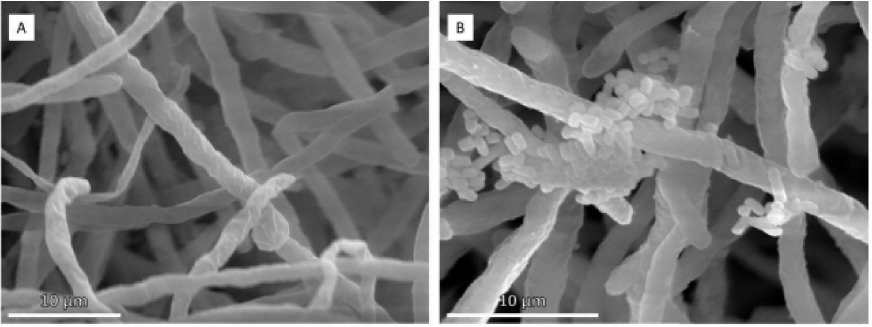
Figure 5. Scanning electron micrographs of T. amestolkiae – L. plantarum M9MG6-B2 consortia in the absence ( A ) or presence ( B ) of